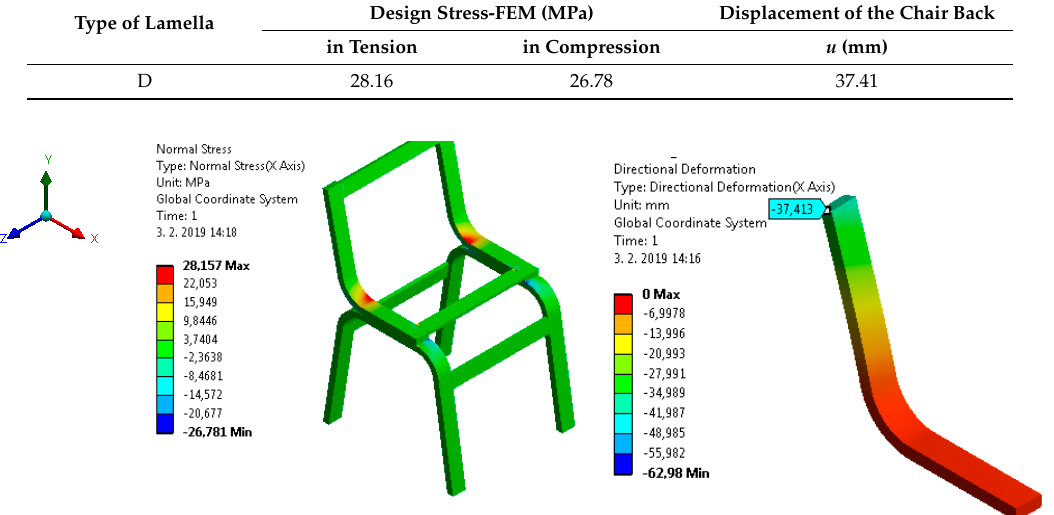
Figure 8. FEM visual outputs of stresses and displacement of the chair back with thickness of 21 mm when loading is 150 kg. Left: Values of design compression (23,781 MPa) and tensile stresses (28,157 MPa), right: value of the backward displacement of the chair back (37,413 mm).